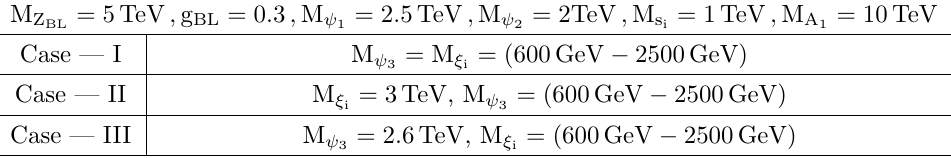
Table 4 . Benchmark scenarios considered for calculating decay widths of Z BL